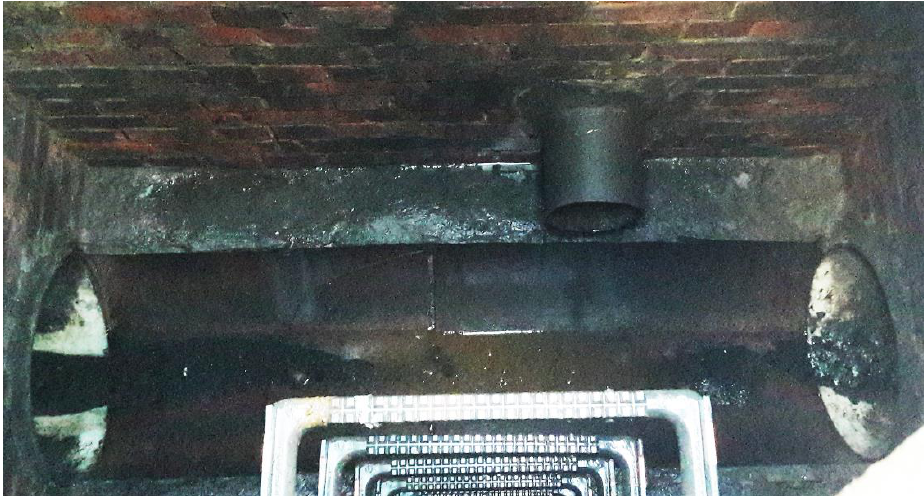
Figure 17. Visual inventory of a sewage drain with visible main string and transverse connection.